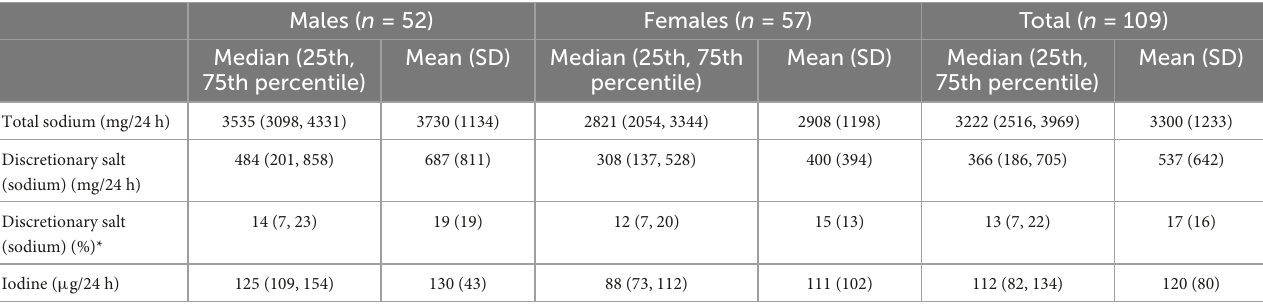
TABLE 2 Urinary excretion of sodium, sodium intake from discretionary salt calculated from urinary lithium and urinary excretion of iodine.